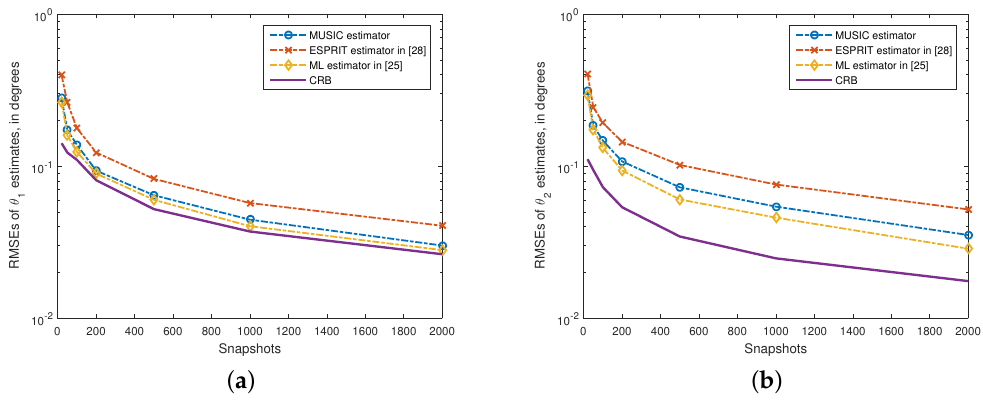
Figure 4. RMSEs of θ 1 and θ 2 estimates versus the number of snapshots. ( a ) θ 1 = 10 ◦ ; ( b ) θ 2 = 20 ◦ , ρ 2 = 0.5. SNR = 10 dB. 500 independent